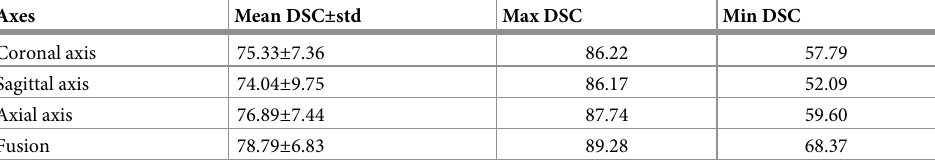
Table 1. Evaluation for coarse segmentation of three axes and fusion segmentation is reported in the table. Axes Mean DSC ± std Coronal